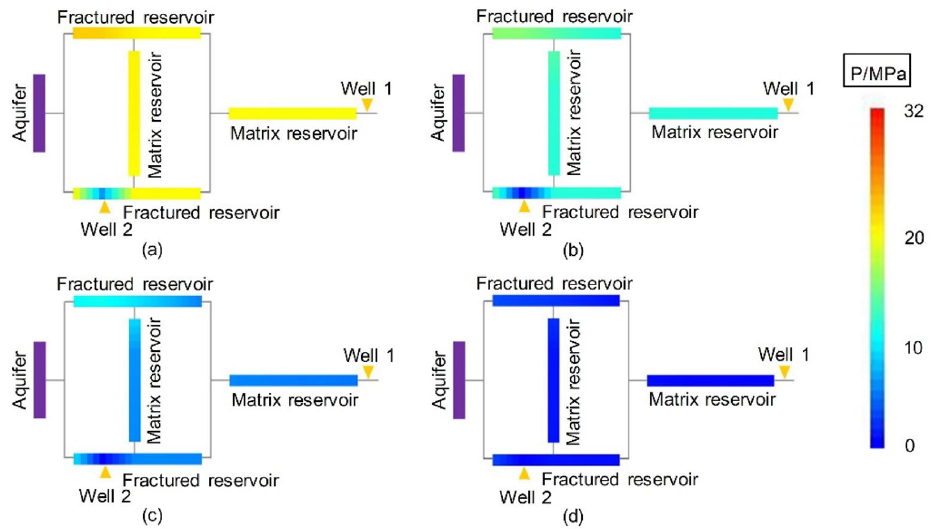
Figure 16. Pressure distributions at different stages of Experiment 2-2 (Well 2 is at Point B): ( a ) produced for 10 min, ( b ) produced for 20 min, ( c ) produced for 30 min, and ( d ) gas reservoir production halted at 105